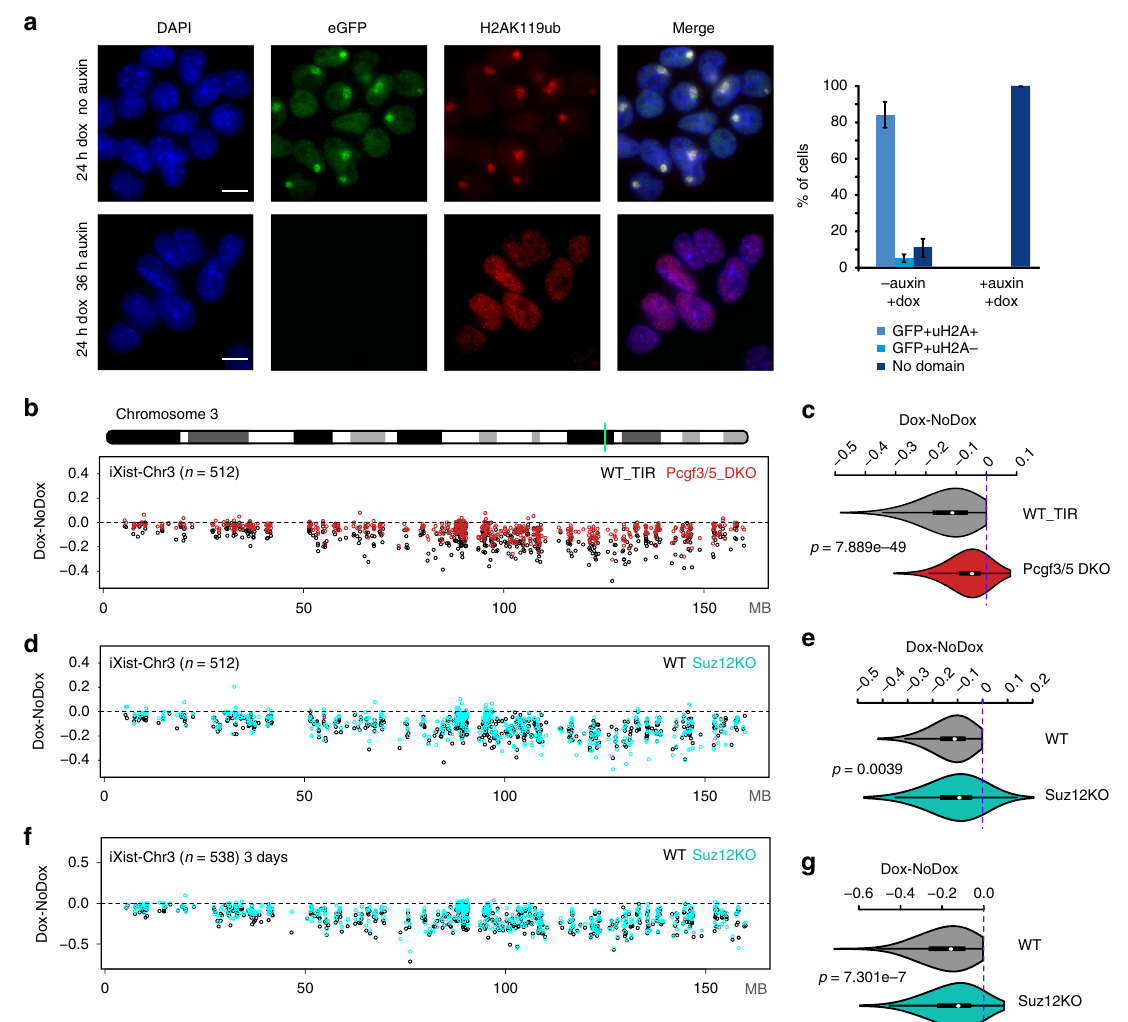
Fig. 5 Divergent roles for PRC1 and PRC2 in Xist-mediated silencing. a Immuno fl uorescence illustrating Auxin-induced degradation of Pcgf3-GFP-AID (green) and resulting loss of Xi-H2AK119ub domains (red) as seen in iXist-Chr3 Pcgf5 null mESCs following Xist RNA induction for 1 day. Bar chart on the right shows proportion of cells with indicated phenotype in control ( − auxin, + dox) and after 36 h of auxin treatment ( + auxin, + dox) based on scoring >40 cells in three independent experiments. Error bars indicate standard deviation. DNA is counterstained with DAPI (blue). Scale bar is 10 μ m. b Allelic silencing across Chr3 after 1 day of Xist RNA induction in WT and Pcgf3/5 DKO iXist-Chr3 cells. Mean value of difference of allelic ratio for each gene with an informative SNP was calculated from biological replicates as detailed in Supplementary Table 4. Green line on Chr3 ideogram indicates location of the Xist transgene. c Violin plot summarising data in b . P values were calculated using one-sided Wilcoxon rank-sum test. d Allelic silencing across Chr3 after 1 day of Xist RNA induction in WT and Suz12 null (KO) iXist-Chr3 cells. Mean value of difference of allelic ratio for each gene with an informative SNP was calculated from biological replicates as detailed in Supplementary Table 4. e Violin plot summarising data in d . P values were calculated using